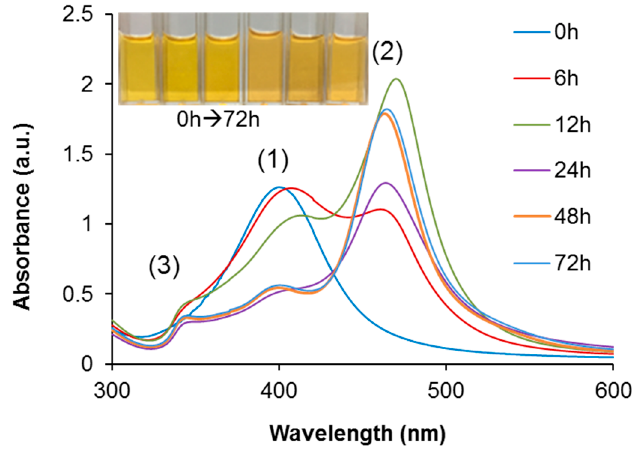
Figure 2. UV–Vis spectra of silver nanoparticles at different LED irradiation times.